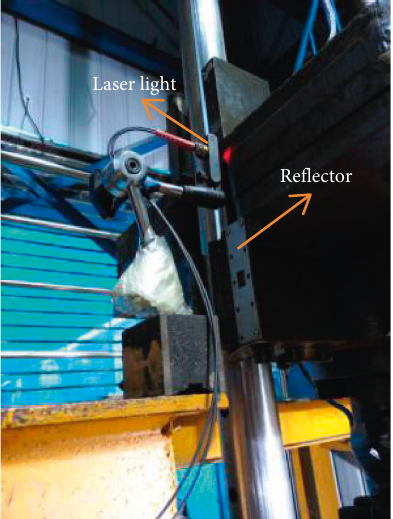
Figure 3: Drop hammer.